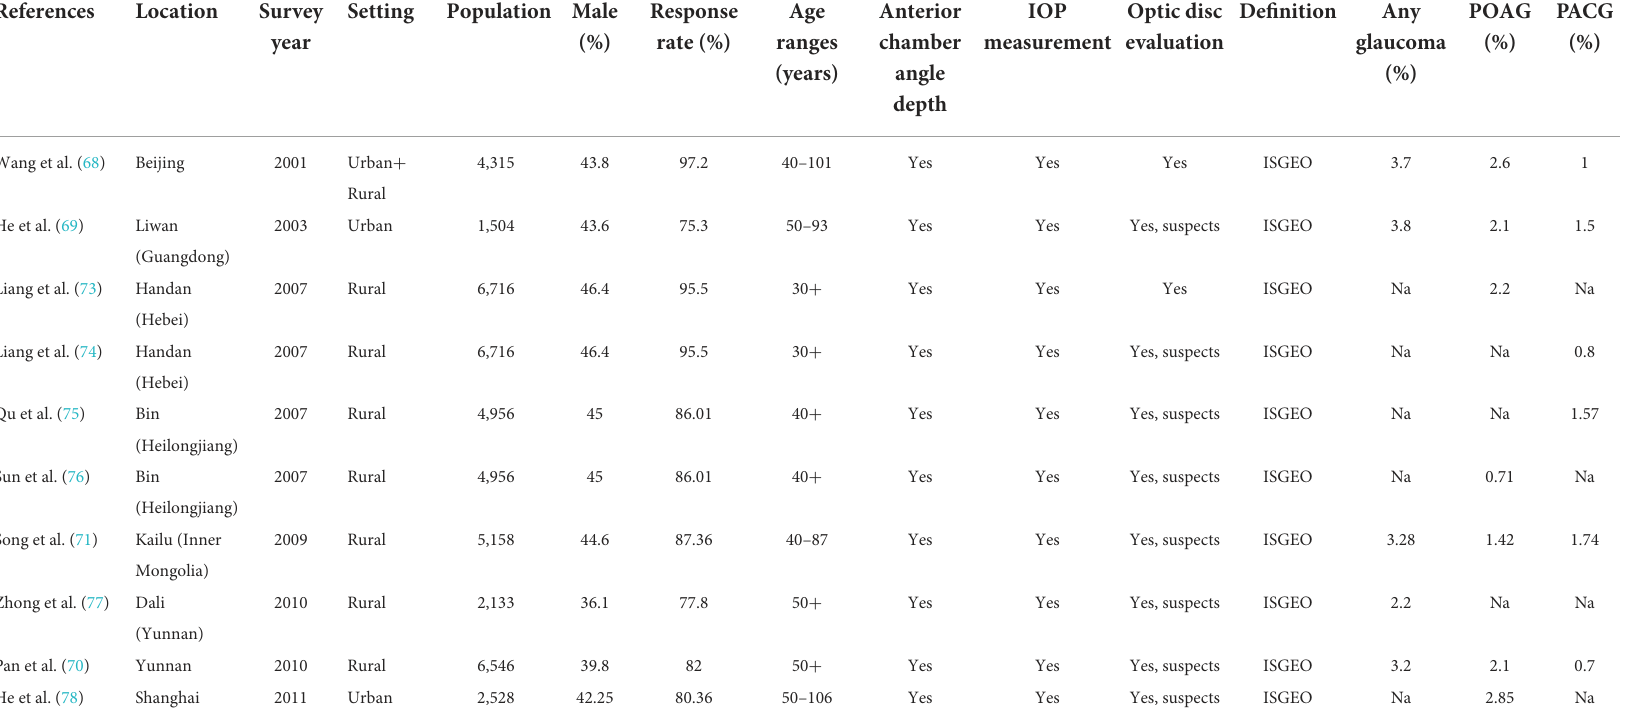
TABLE 2 Detailed characteristics of the main studies on glaucoma prevalence in mainland